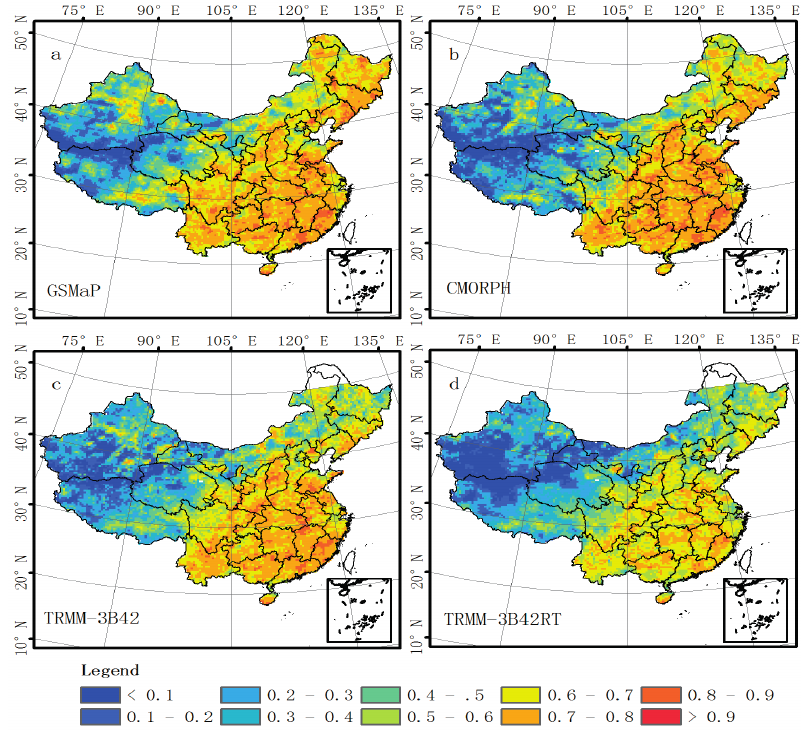
Figure 8. Distribution of correlation coefficients over the Chinese Mainland from 2003 to 2006. ( a ) GSMaP, ( b ) CMORPH, ( c ) TRMM 3B42 and ( d ) TRMM